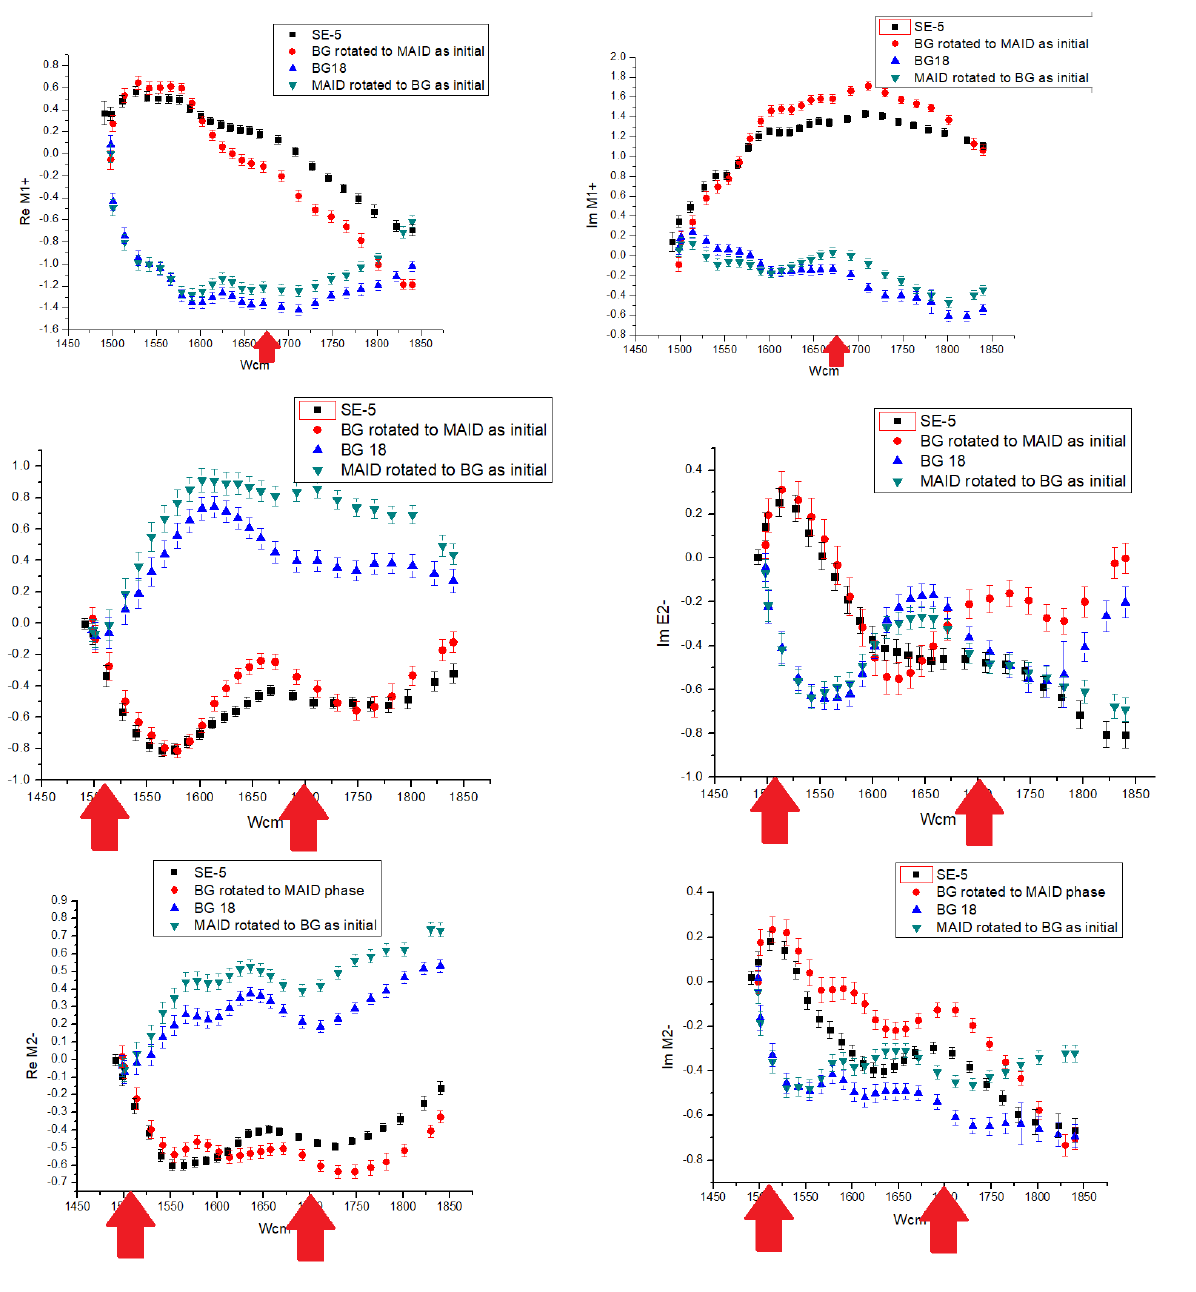
Figure 6: (Color online) Final set of η -photoproduction partial wave amplitudes obtained in ref. [2] for higher multipoles.